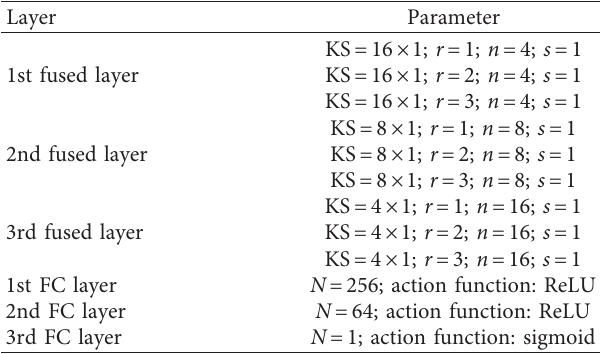
Figure 8: Loss function curve for the training